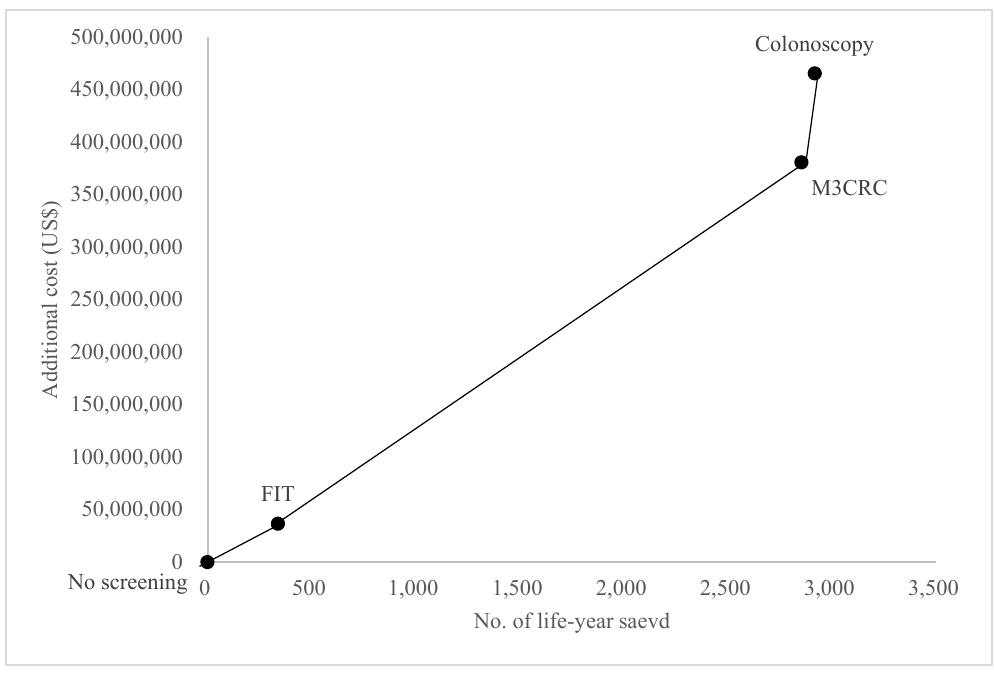
Figure 2. Cost-effectiveness analysis for the screening tests.